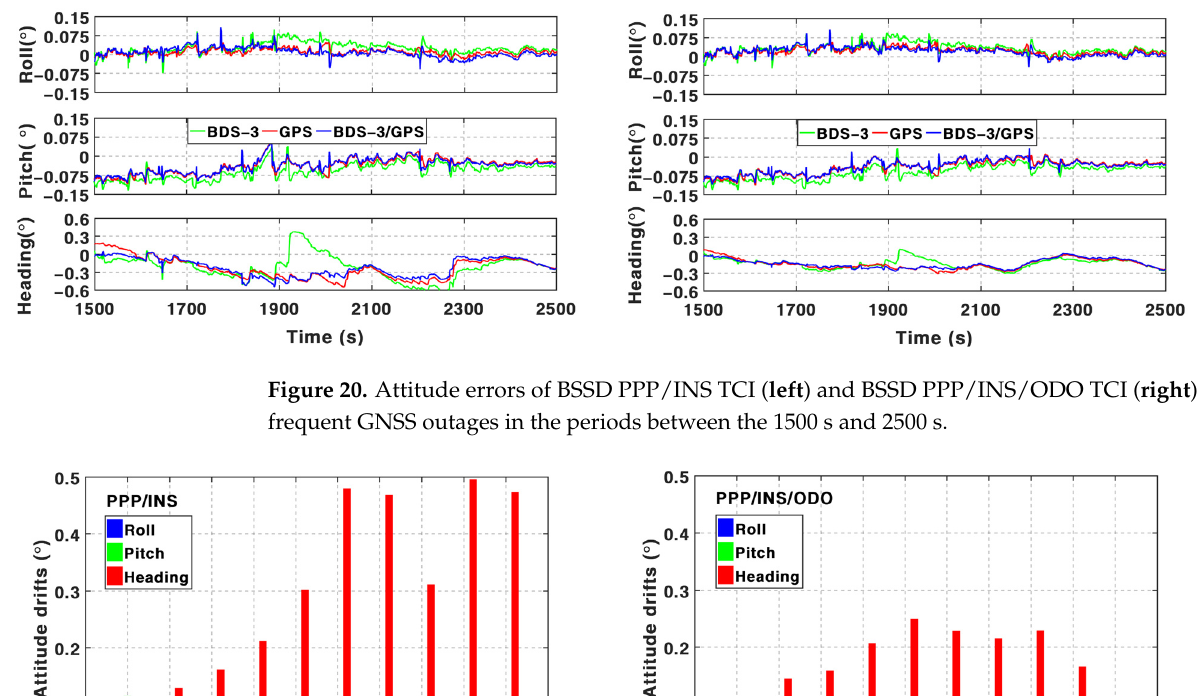
GNSS. different GNSS.